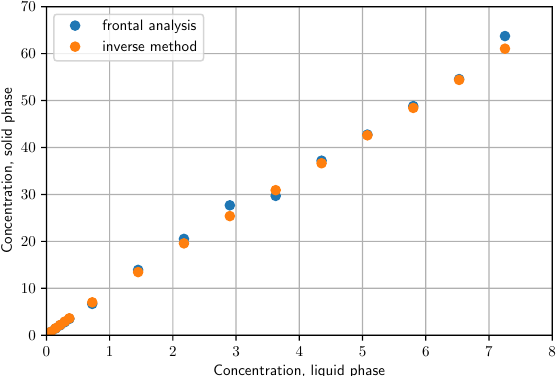
Figure 6. Isotherm points determined by the Frontal Analysis (blue) and by the unbiased Inverse Method